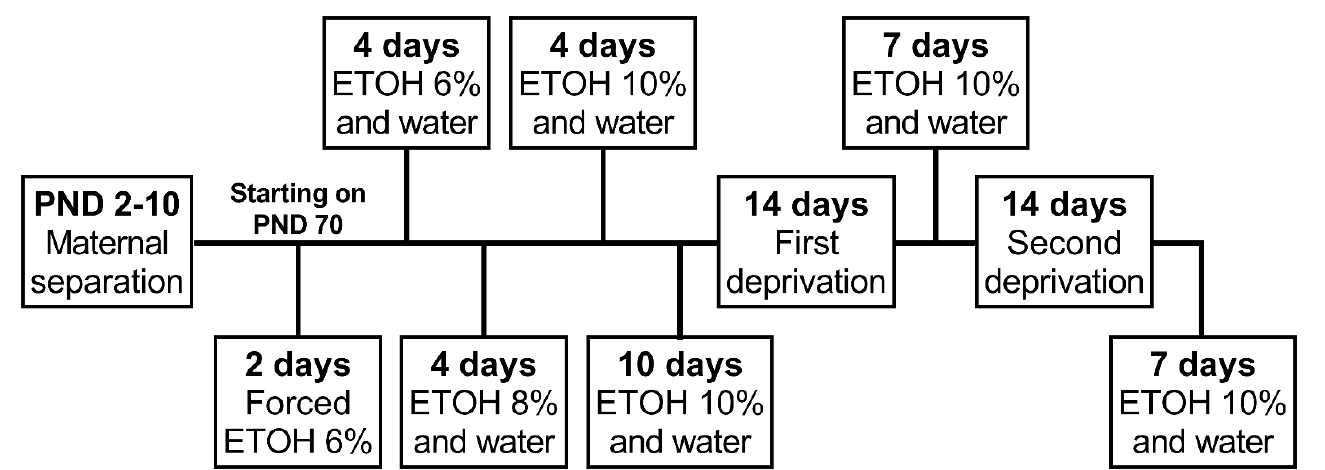
Figure 1. Experimental procedure timeline. Female and male rats were exposed to brief or prolonged maternal separation during early life and submitted to an alcohol deprivation effect protocol during adulthood. PND, postnatal day; ETOH, ethanol.